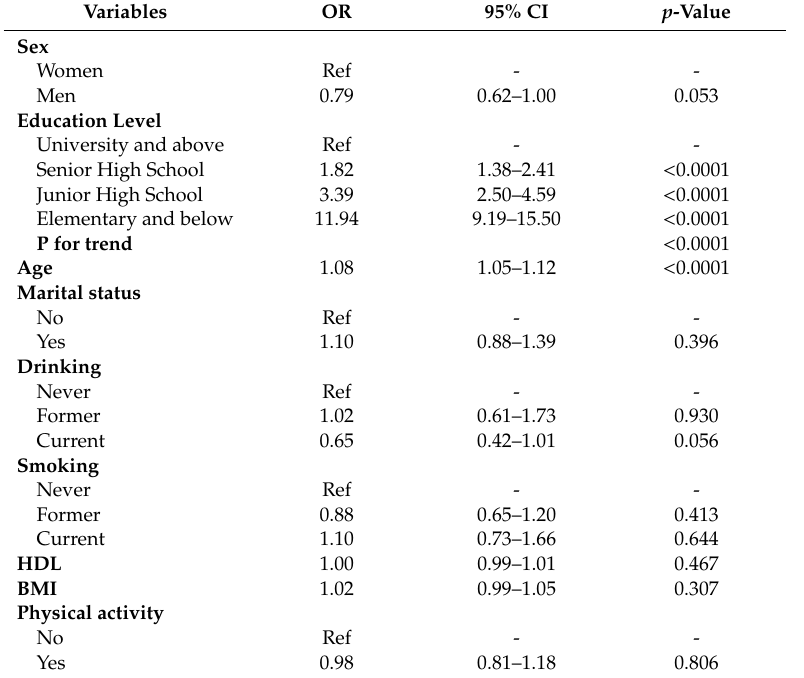
Table 2. Multivariate logistic regression analysis showing associations with MMSE